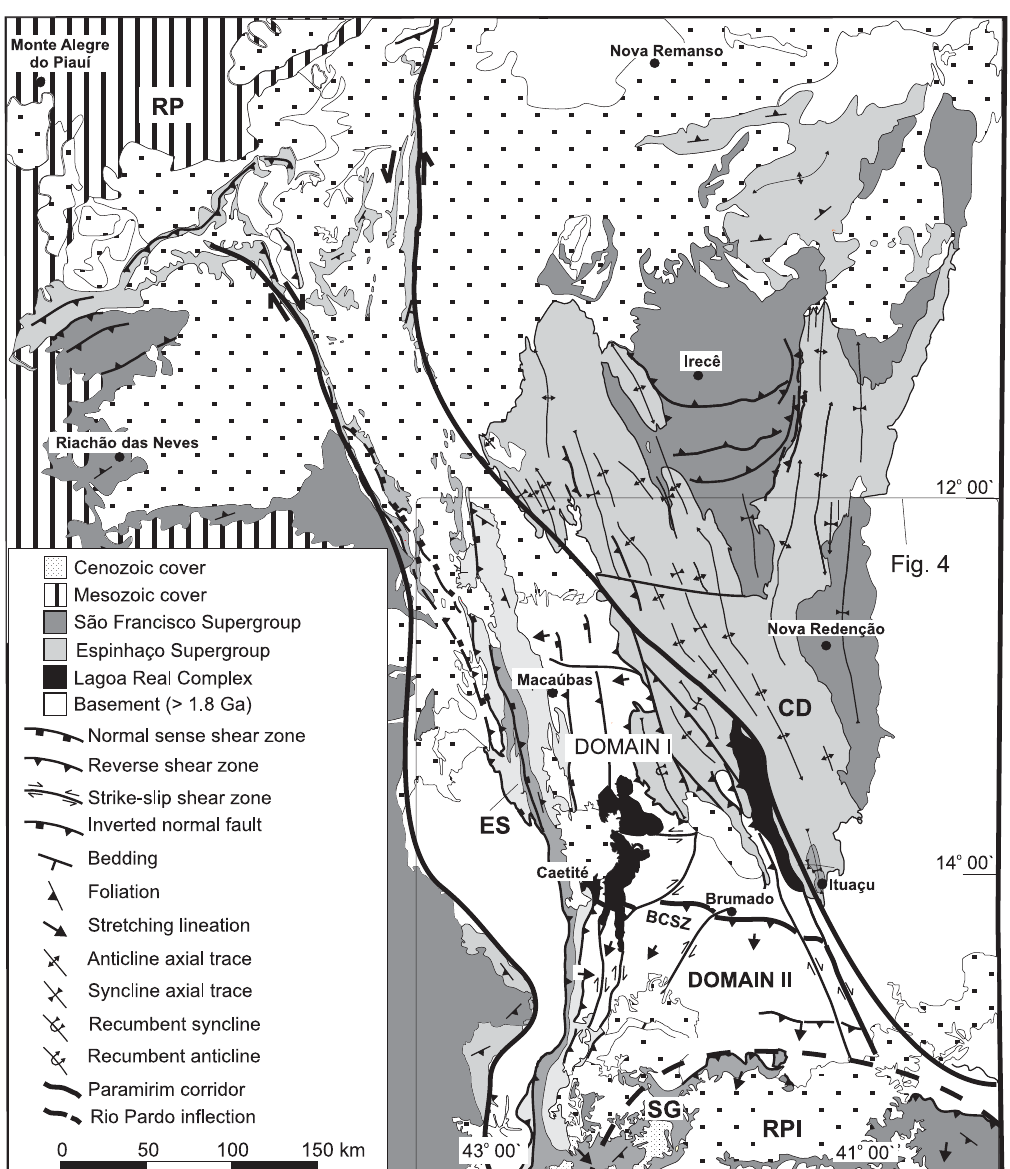
Fig. 2 – Simplified geologic map of the Paramirim aulacogen. The box indicates the location of Figure 4 (Based on Schobbenhaus et al. 1981, Barbosa and Dominguez 1996, A. Danderfer F BCSZ – Brumado-Caetité shear zone, ES – Espinhaço Setentrional, CD – Chapada Diamantina, RP – Rio Preto belt, RPI – Rio Pardo salient of the Araçuaí belt, SG – Serra Geral